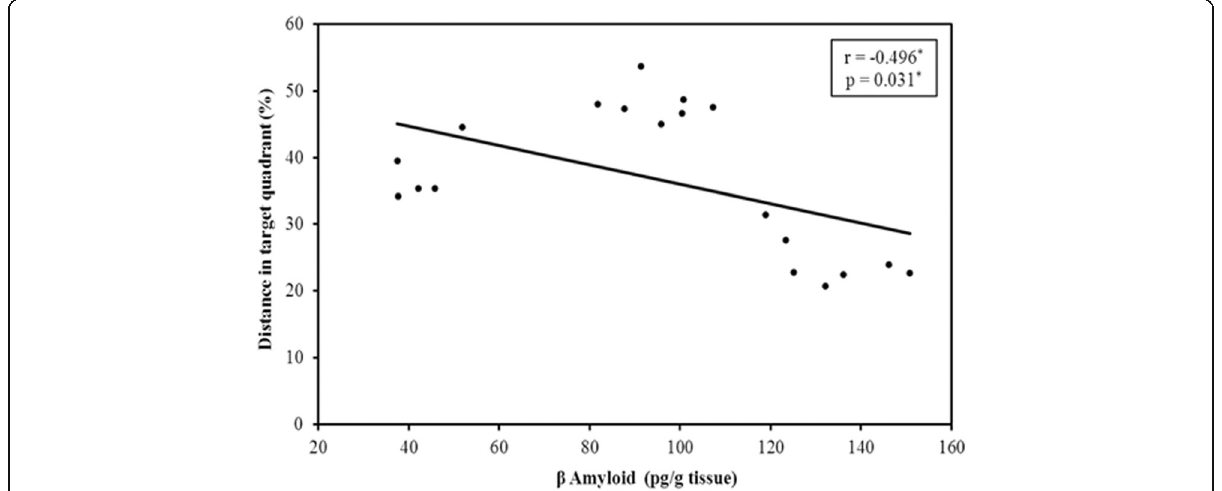
Fig. 5 Correlation between A β 1-42 (pg/ g tissue) and the distance swum in target quadrant (%) in the total samples (groups I, II, and